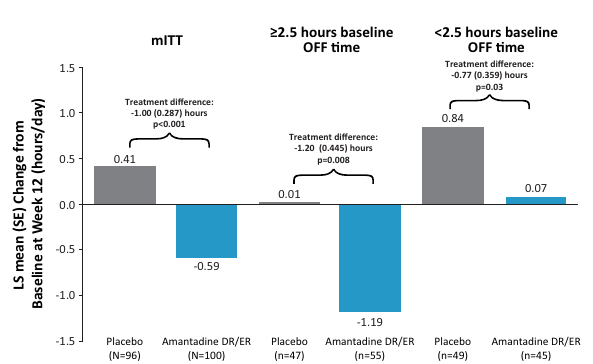
Fig. 2 LS Mean (SE) Change from Baseline to Week 12 in OFF time. Data are for the mITT population and strati fi ed by baseline OFF time ( ≥ 2.5 h and < 2.5 h subgroups). P -values are based on comparisons between amantadine DR/ER versus placebo from an MMRM model with change from baseline as the dependent variable and baseline values as a covariate. The model includes categorical effects